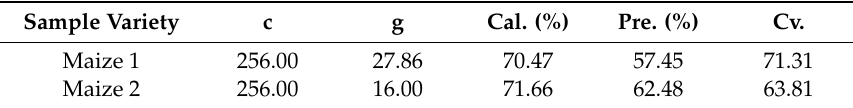
Table 5. The classification accuracy of SVM models using the optimal wavelengths selected by second-order derivative spectra.